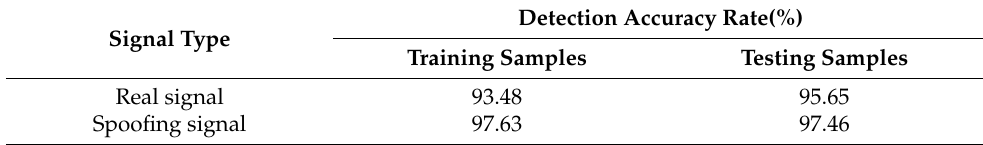
Table 3. Deception detection model.